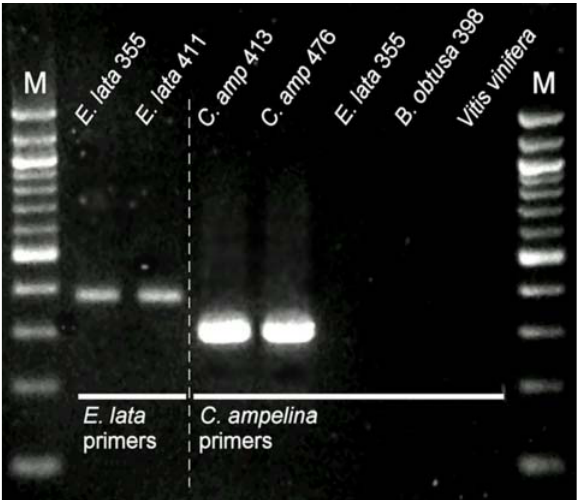
Fig. 2. PCR amplifications using the species-specific primers Lata 1/Lata 2-2 and Camp-1/Camp-2R on DNA extracts from different sources. M, molecular weight marker, 100 bp DNA ladder (New England BioLabs, Beverly, MA, USA).